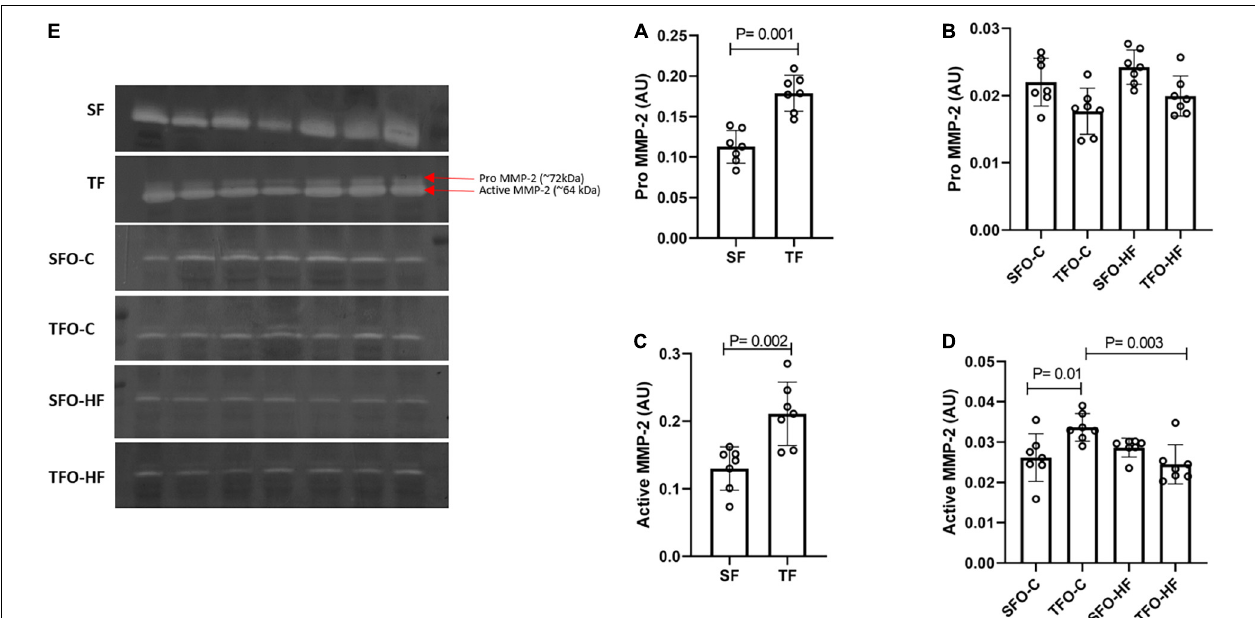
FIGURE 6 | MMP-2 activity in the gastrocnemius muscle of fathers and offspring exposed to control diet and HFD. Optical densitometry of zymographic bands of MMP-2 in arbitrary units (AU). The data are mean ± standard deviation. (A) Pro MMP-2 activity in fathers. (B) Pro MMP-2 activity in offspring. (C) Active MMP-2 activity in fathers. (D) Active MMP-2 activity in offspring. (E) Optical densitometry of zymographic bands. SF, sedentary fathers; TF, trained fathers; SFO-C, offspring from sedentary fathers, exposed to control diet; TFO-C, offspring from trained fathers exposed to control diet; SFO-HF, offspring from sedentary fathers exposed to high-fat diet; TFO-HF, offspring from trained fathers exposed to a high-fat diet ( n = 7 per group).